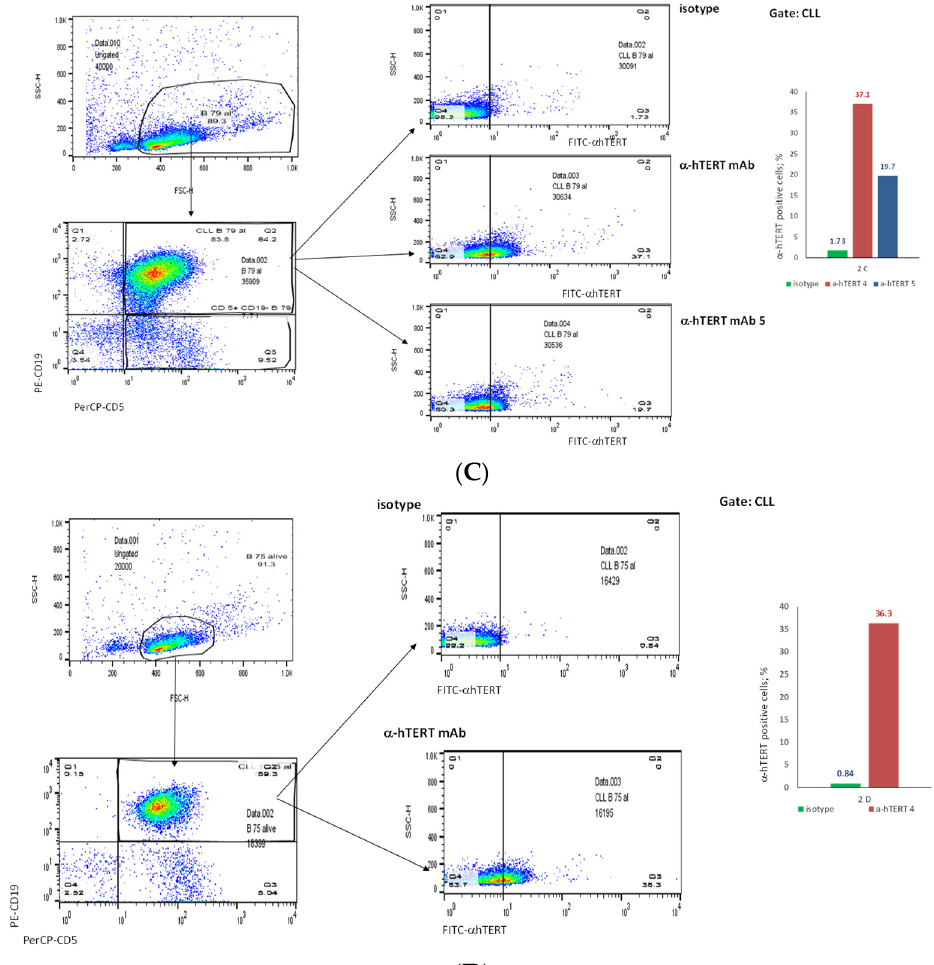
Figure 3. The binding of the α -hTERT mAb to PBMCs of CLL patients. The extent of the binding is shown on the right in each panel. ( A ). Most of α -hTERT positive cells are also CLL positive (CD19+/CD5+). PBMCs of CLL patient first were incubated with α -hTERT mAb or its isotype, then washed and stained with FITC- α -mouse secondary antibody followed by CLL markers PE- CD19/PerCP-CD5 staining. All α -hTERT positive cells were gated and analyzed for CD19/CD5. Overlay flow cytometry dot plot: the isotype is marked with green, the α -hTERT positive cells—in red. ( B ). CLL (CD19+/CD5+) Cells obtained from Patients with CLL are α -hTERT Positive. CLL cells from patient were gated according to the phenotype markers CD19/CD5, incubated with the α -hTERT mAb or its isotype IgG and stained with FITC-a-mouse secondary Ab. Flow cytometry dot plots show the binding α -hTERT mAb to CD19+/CD5+ cells and almost no binding of the iso- type IgG. ( C ). Ex vivo binding of the α -hTERT mAb to CD19+/CD5+ cells from a newly diagnosed patient with CLL. Flow cytometry analysis: incubation with α -hTERT mAb or its isotype, staining with FITC- α -mouse secondary antibody followed by CLL markers PE-CD19/PerCP-CD5. ( D ). Ex vivo binding of the α − hTERT mAb to CD19+/CD5+ Cells from Patient with CLL during treatment. Flow cytometry analysis was conducted as above.